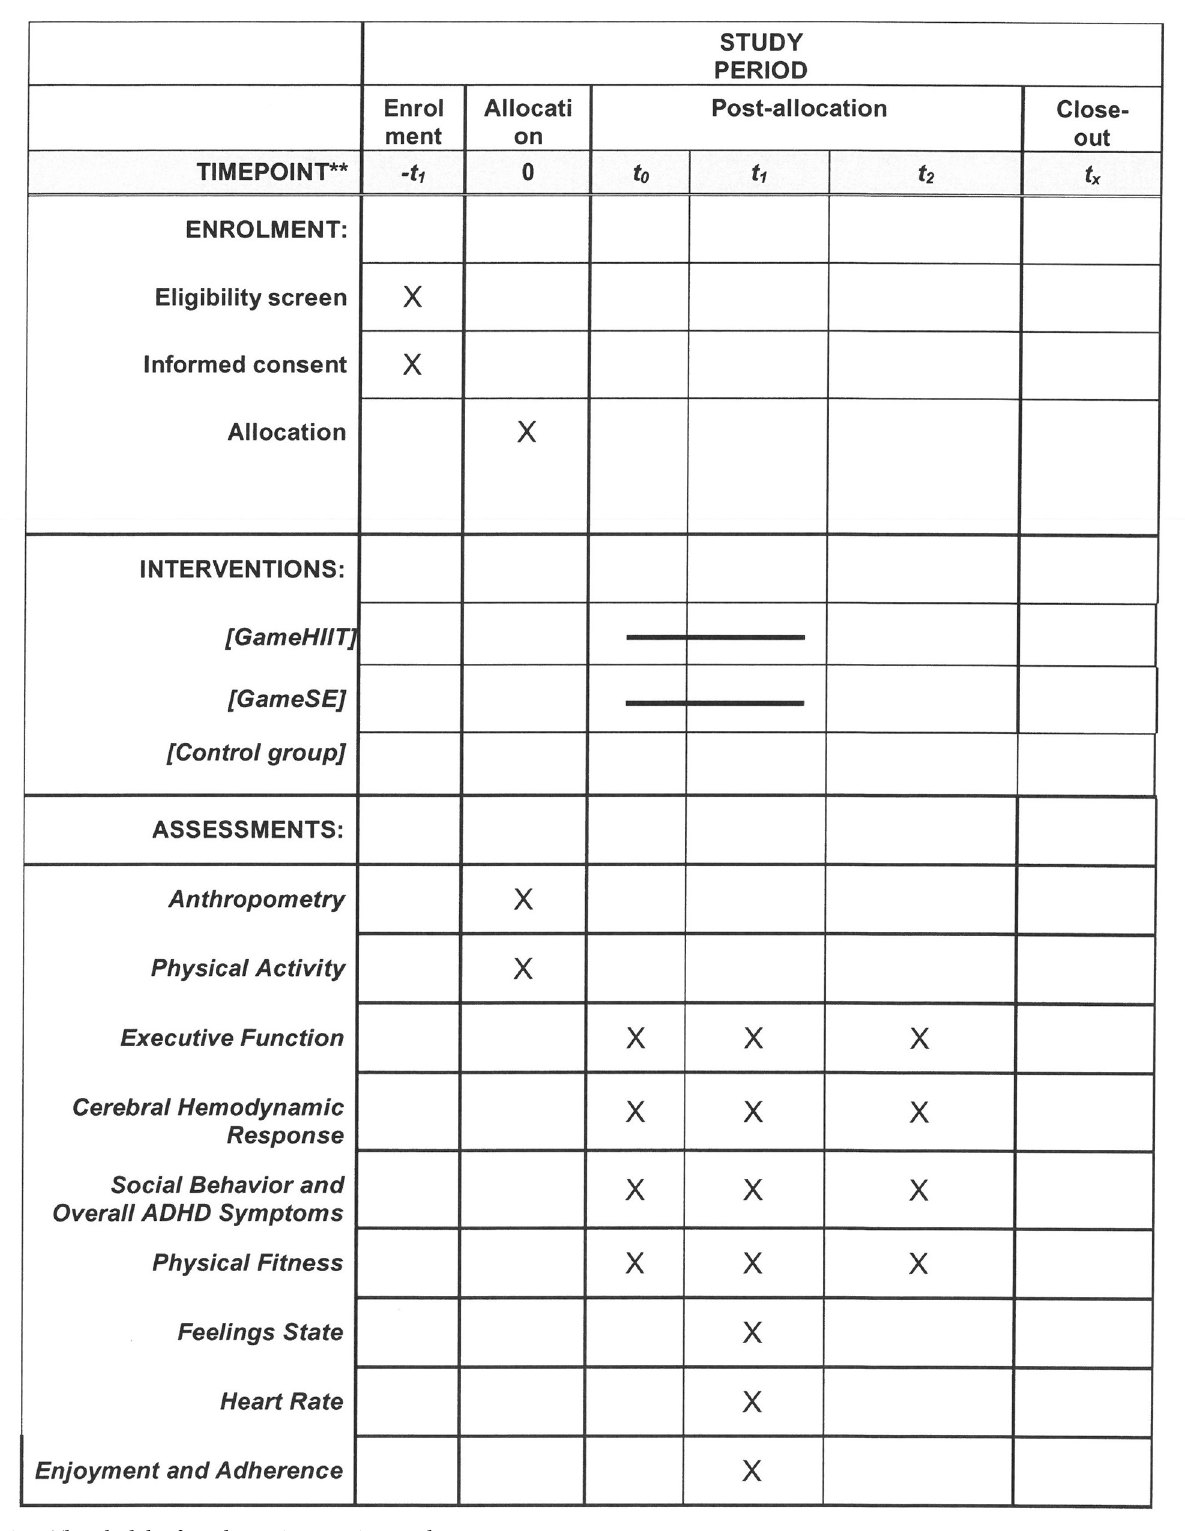
PLOS ONE | https://doi.org/10.1371/journal.pone.0272121 July 28,